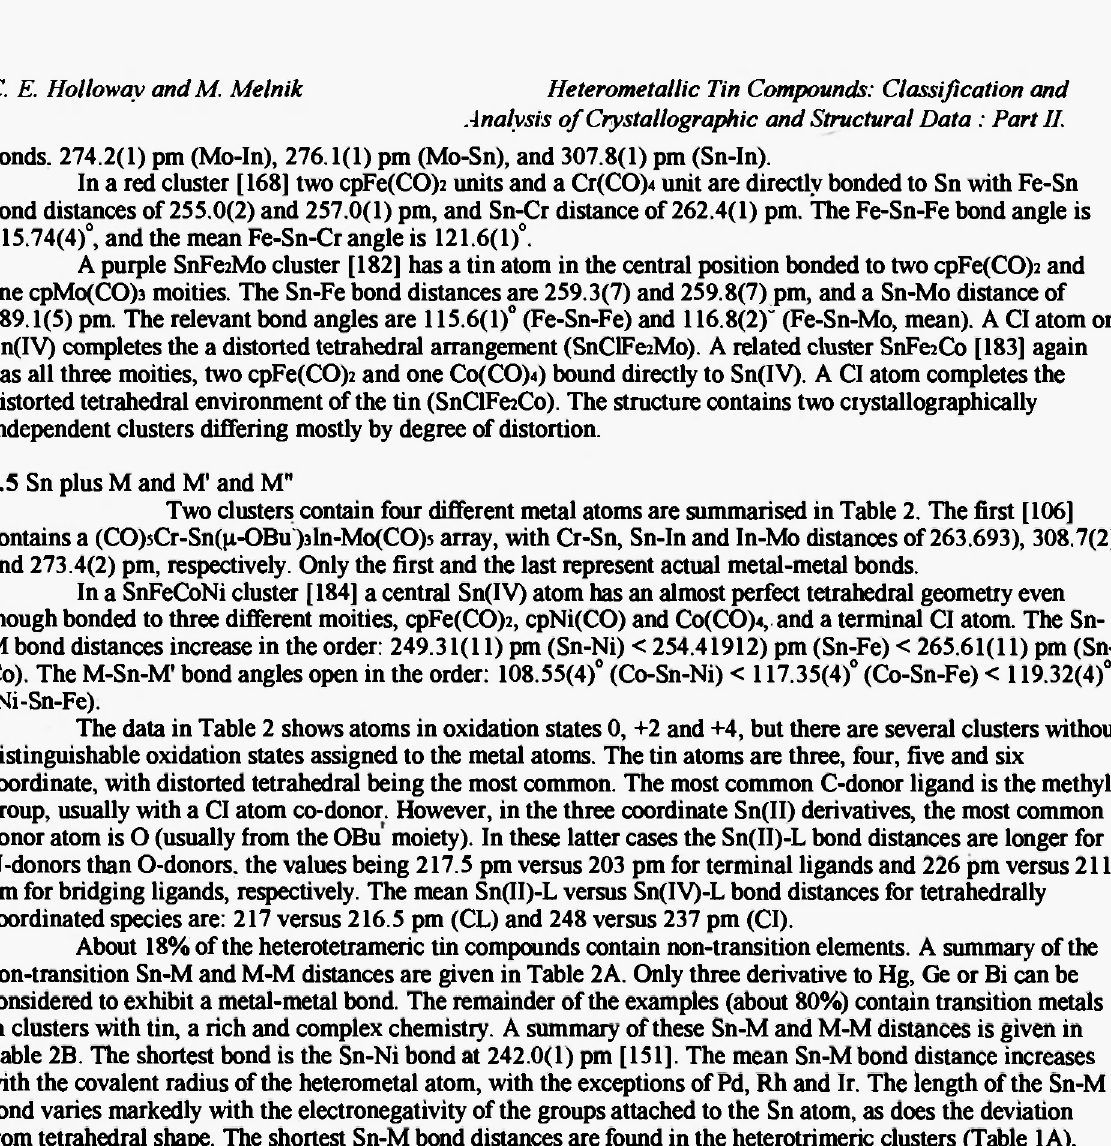
Table 2A. Summary of Sn-M and M-M Distances in Heterotetrameric Clusters (Non-Transition) Cov. Radius